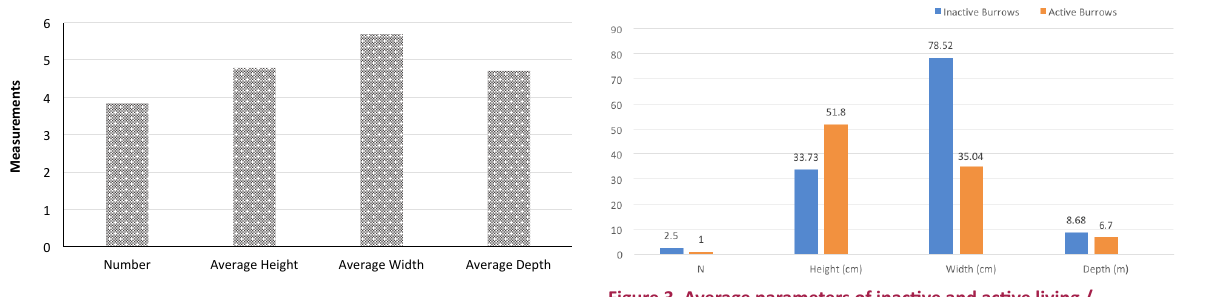
Figure 3. Average parameters of inactive and active living / permanent / resting burrows of the Indian Pangolin Manis crassicaudata recorded in Mansehra